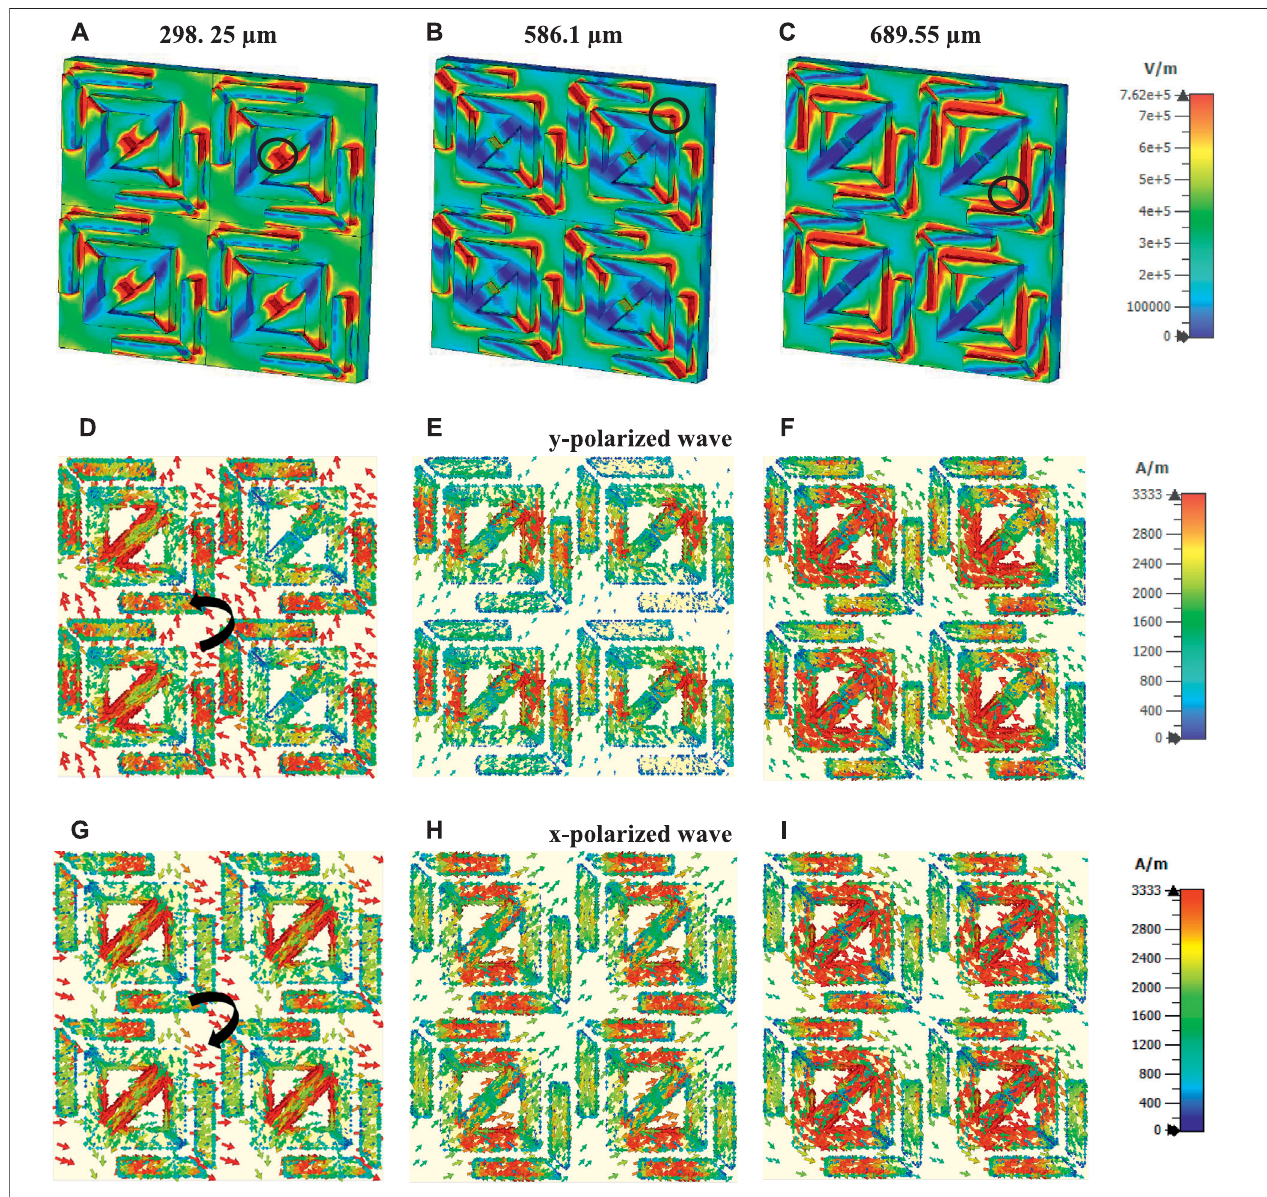
FIGURE 5 | (A – C) Electric fi eld distributions and surface current circulations for (D – F) y-polarized wave and (G – I) x-polarized wave at 298.25, 586.1, and 689.55 µm, respectively.